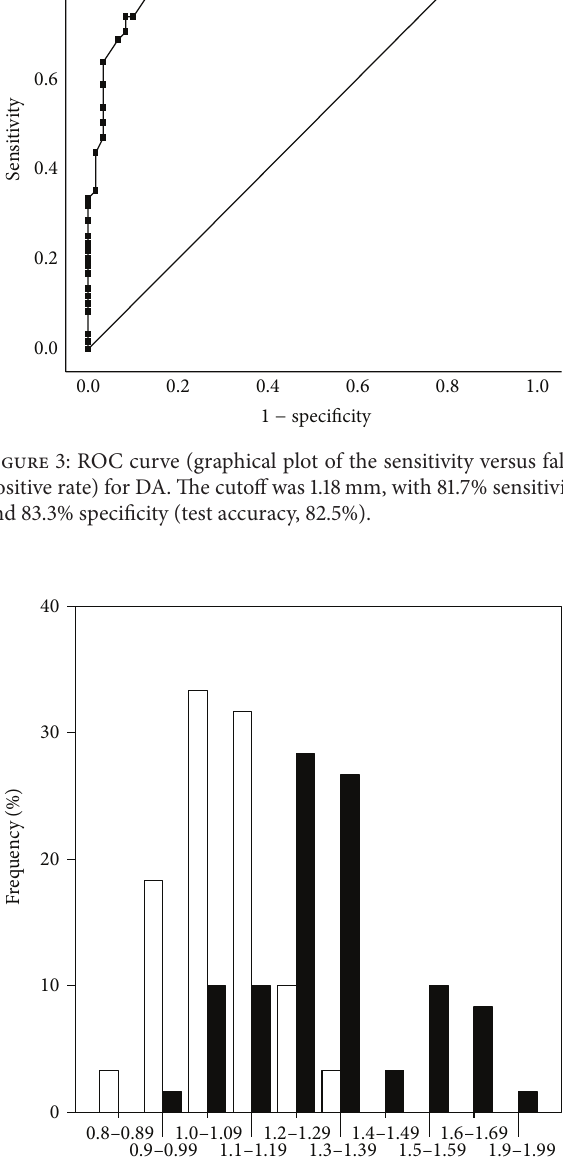
normal corneas. The keratometry values, astigmatism, ante- rior chamber depth, and anterior chamber volume were significantly higher in the KC group than in the control group, whereas the corneal thickness, anterior chamber angle, and corneal volume were lower in the KC group. As in some other studies, the corneal thickness and corneal volume were